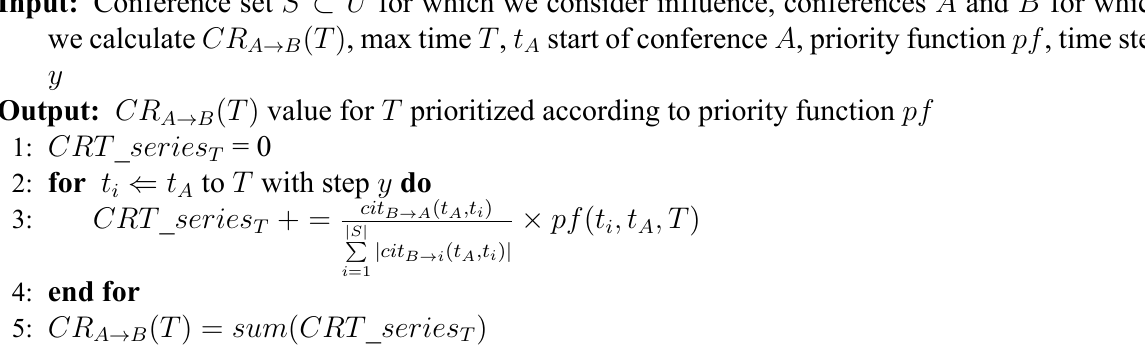
( T ) for a particular time A ! B